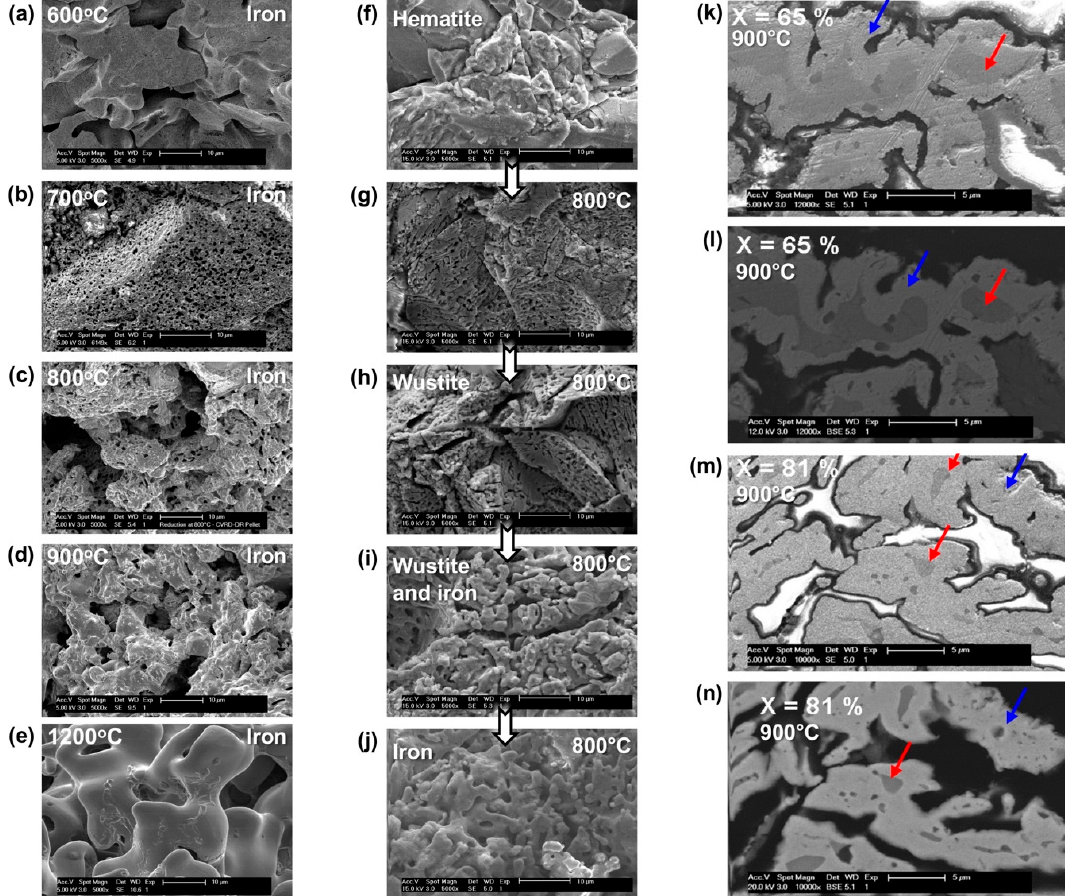
Figure 6. SEM micrographs showing the morphological changes at the granular scale in CVRD ‐ DR pellets; ( a–e ): iron grains after reduction at different temperatures; ( f–j ): grains in different stages of reduction at 800 °C; ( k–n ): polished cross ‐ sections at conversion degrees of 65% ( k,l ) and 81% ( m,n ) for samples reduced at 900 °C, the red arrows point to shrinking wustite cores (dark gray) surrounded with a spreading layer of iron (light gray), indicated by the blue arrows. All images were taken with SE (secondary electrons), except ( l ) and ( n ), which were taken with BSE (backscattered electrons). The gas used for the reduction was 2 L/min H 2 ‐ He (60–40 vol. %) in a thermobalance.